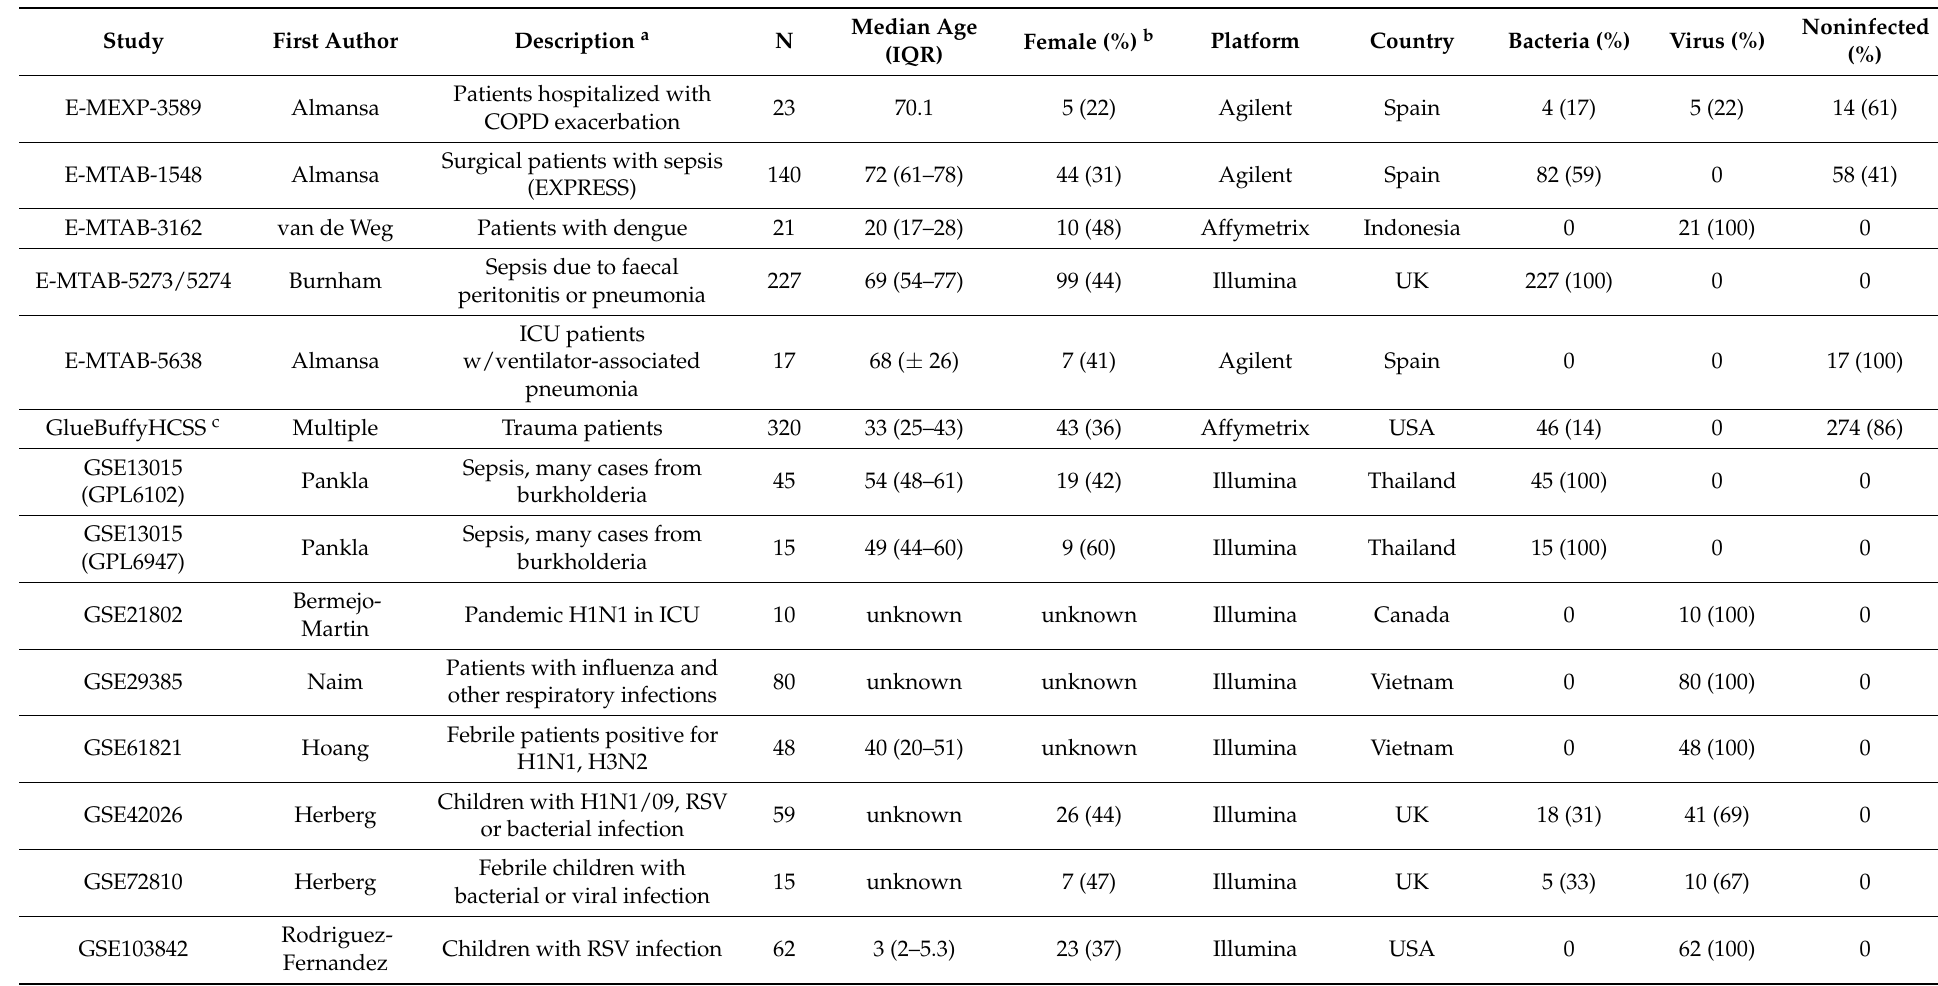
Table 2. Patient characteristics and composition of datasets used in training for the marker swap optimization. ID = Infectious Disease; COPD = Chronic Obstructive Pulmonary Disease; ICU = Intensive Care Unit; CAP = Community-Acquired Pneumonia; SIRS = Systemic Inflammatory Response Syndrome; TB = Tuberculosis; SJIA = Systemic Juvenile Idiopathic Arthritis; HRV = Human Rhinovirus; RSV = Respiratory Syncytial